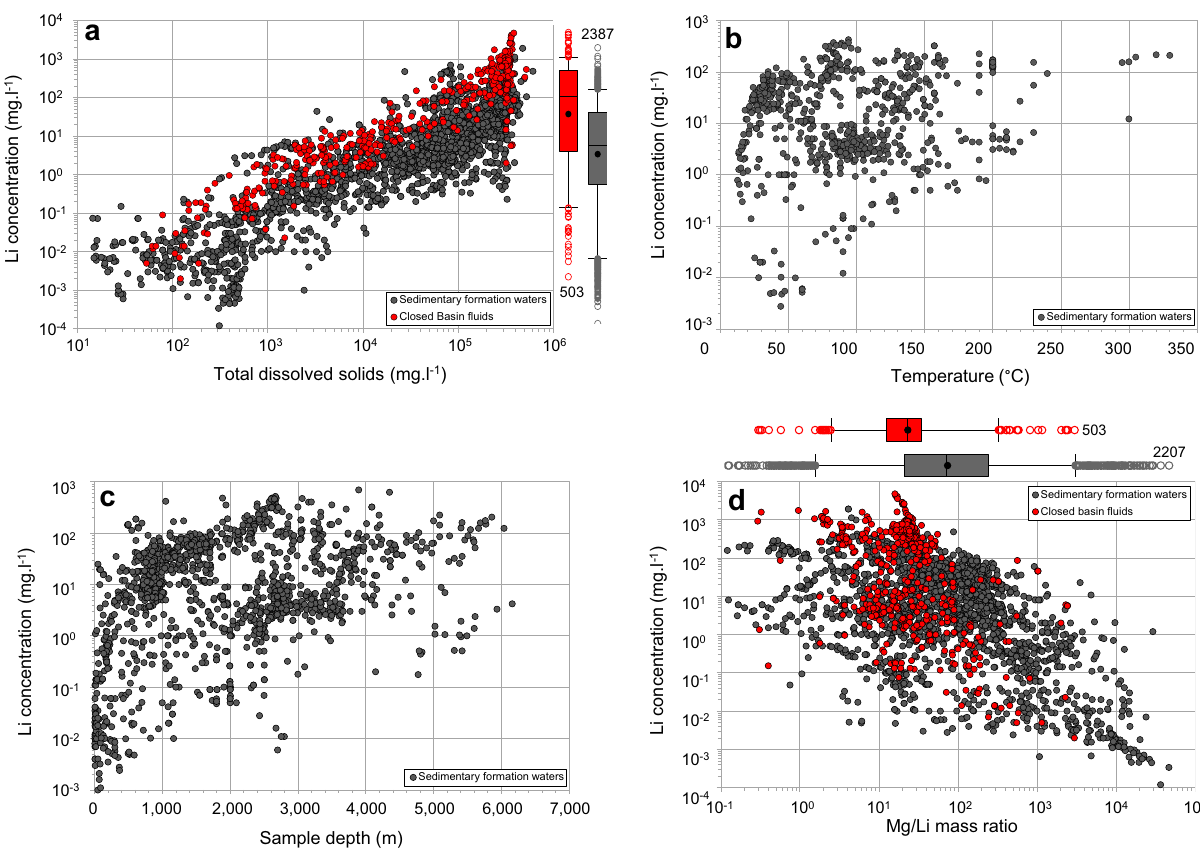
Figure 2. Lithium concentration in formation waters from sedimentary basins and closed basin brines worldwide as a function of various parameters. ( a ) Lithium concentration vs total dissolved solids. ( b ) Lithium concentration vs temperature. ( c ) Lithium concentration vs sample depth. ( d ) Lithium concentration versus Mg/ Li mass ratio. For box plots, the lower whiskers, bottoms of boxes, central lines, circles, tops of boxes and upper whiskers represent 5th, 25th, 50th, average, 75th and 95th percentiles, respectively; circles below and above the whiskers represent outliers. The numbers refer to the number of data.